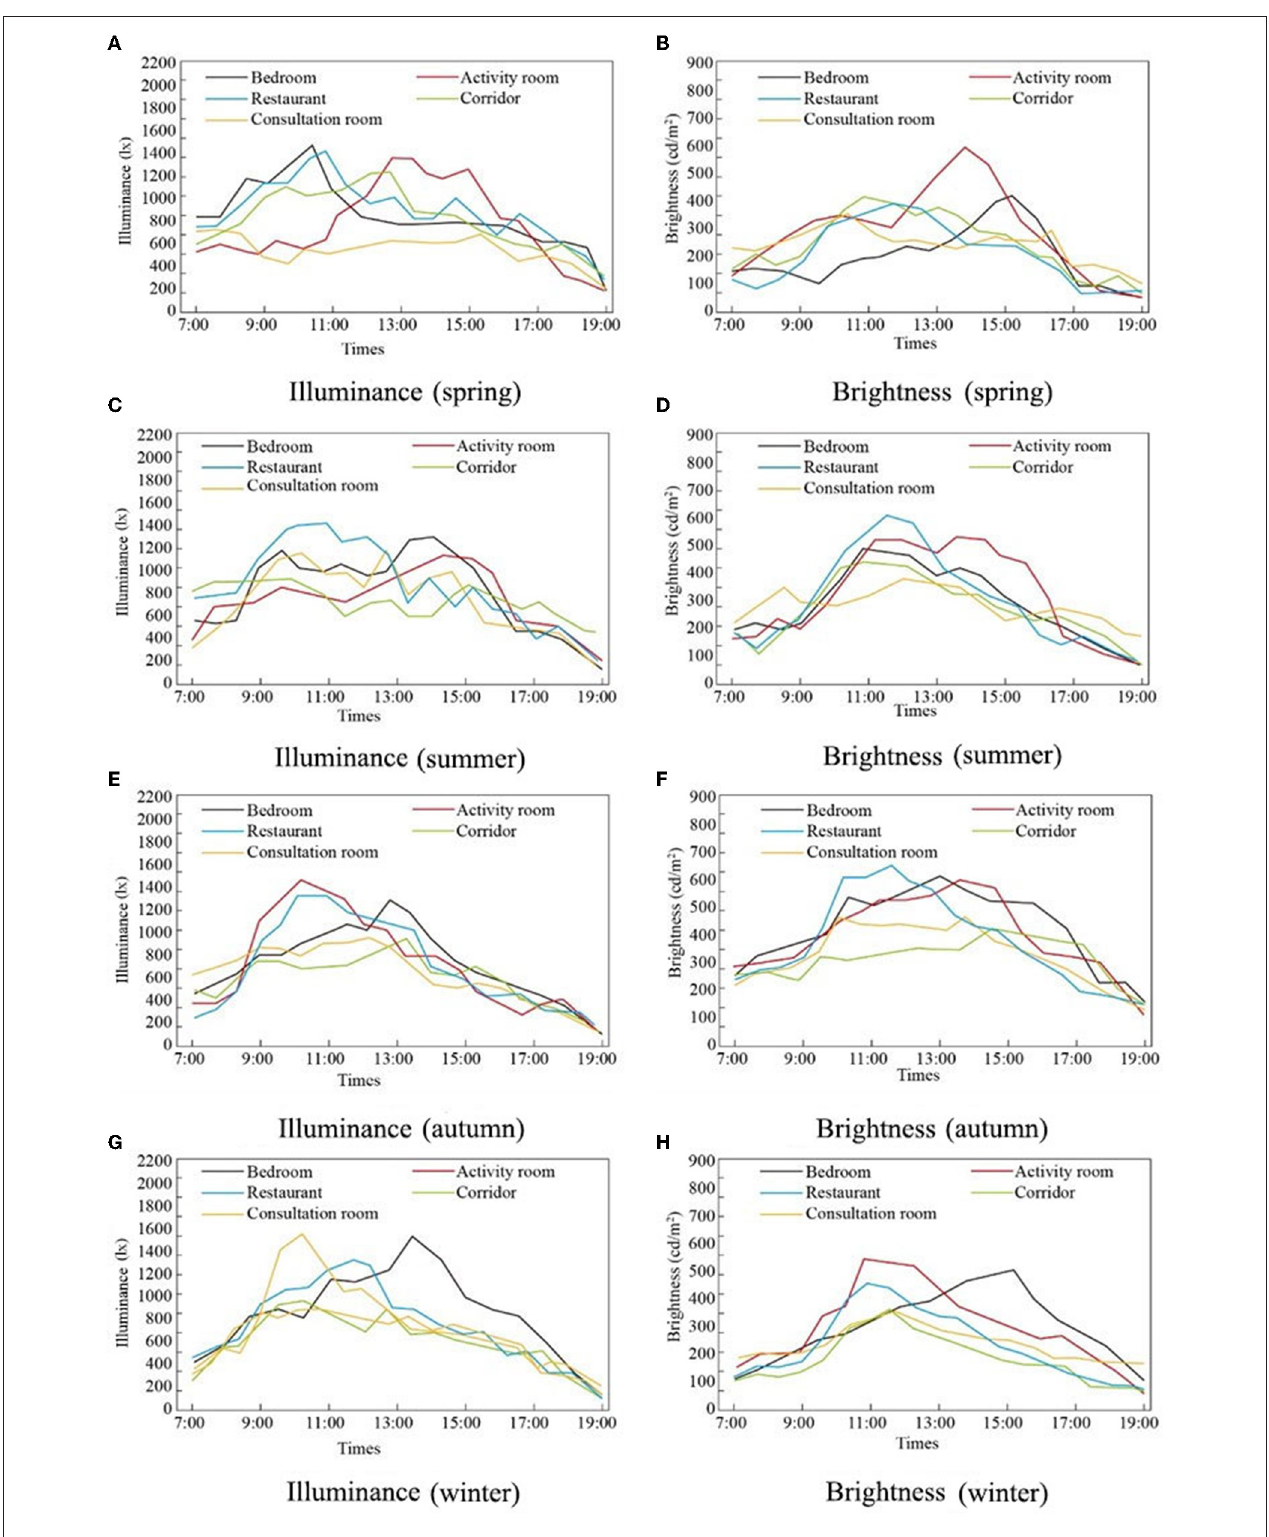
FIGURE 5 | Illuminance and brightness measurement in different seasons and different rooms. (A) Illuminance (spring), (B) Brightness (spring), (C) Illuminance (summer), (D) Brightness (summer), (E) Illuminance (autumn), (F) Brightness (autumn), (G) Illuminance (winter), and (H) Brightness (winter).